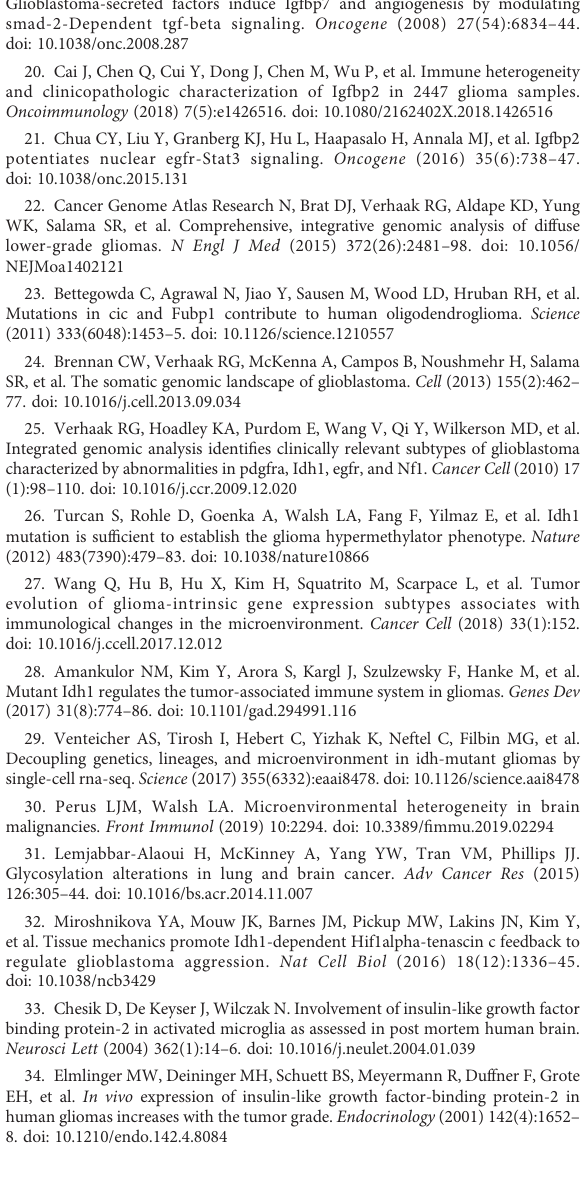
SUPPLEMENTARY FIGURE 4 Relationship between IGFBPScore and other immune characteristics. (A) Differences in stromal cells between Low-risk and High-risk groups. (B-D) Differences in immune-stimulatory genes (B) and immune-suppressive genes (C) tumor microenvironment-related pathways (D) of Low-risk and High-risk groups. (E) Differences in MDSC between Low-risk and High- risk groups. Differences in (F) immune dysfunction and (G) immune escape between Low-risk and High-risk groups. Myeloid derived suppressor cell (MDSC), For all experiments, mean rank, *p<0.05, **p<0.01,